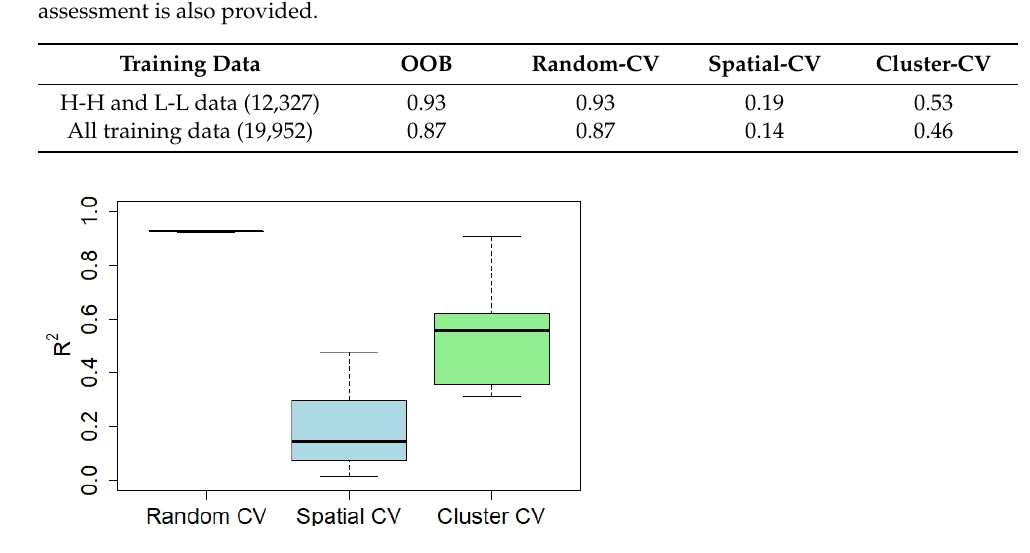
Table 3. QRF performance (R 2 ) for the three different CV schemes. The internal RF OBB error as- sessment is also provided.